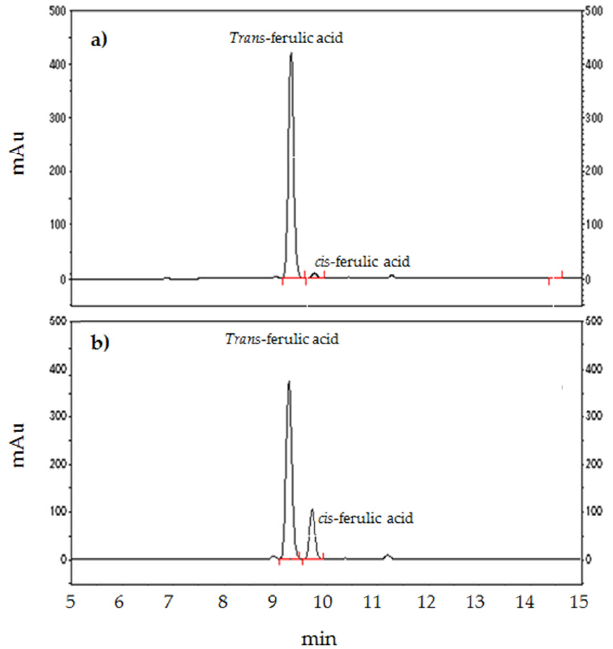
Figure 6. HPLC chromatogram of ferulic acids ( a ) one week after hydrolysis; ( b ) holding after one month.